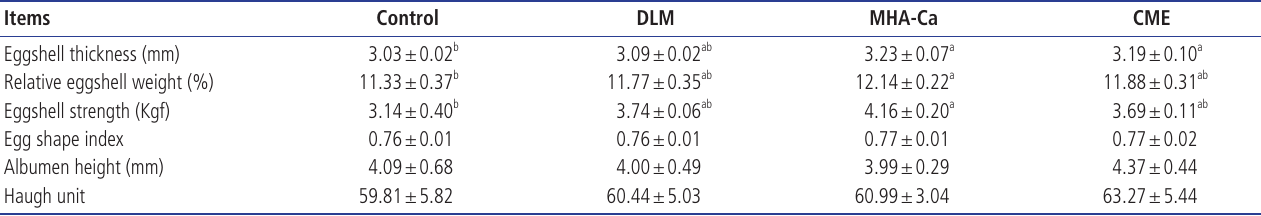
Table 4. Effects of different methionine sources on egg quality of broiler